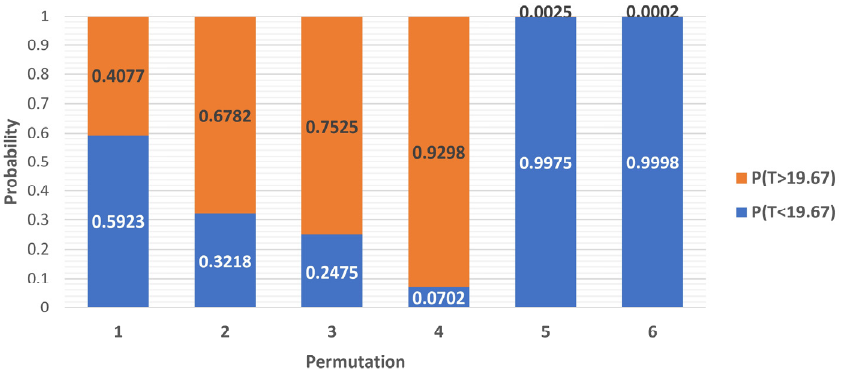
Figure 10. Achieved probabilities for each of the 6 permutations considered in the illustrative case study.